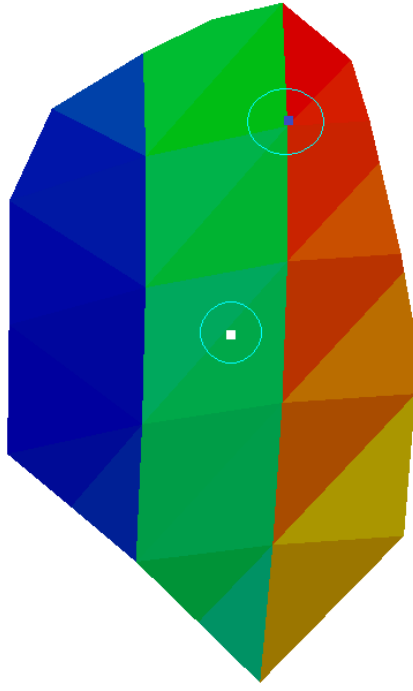
Figure 7. Barycentre computation based on the reference patch ref j ; the original site is the white block in the circle, and the pro- jection on oriPd of the newly computed site is depicted as the blue block in the